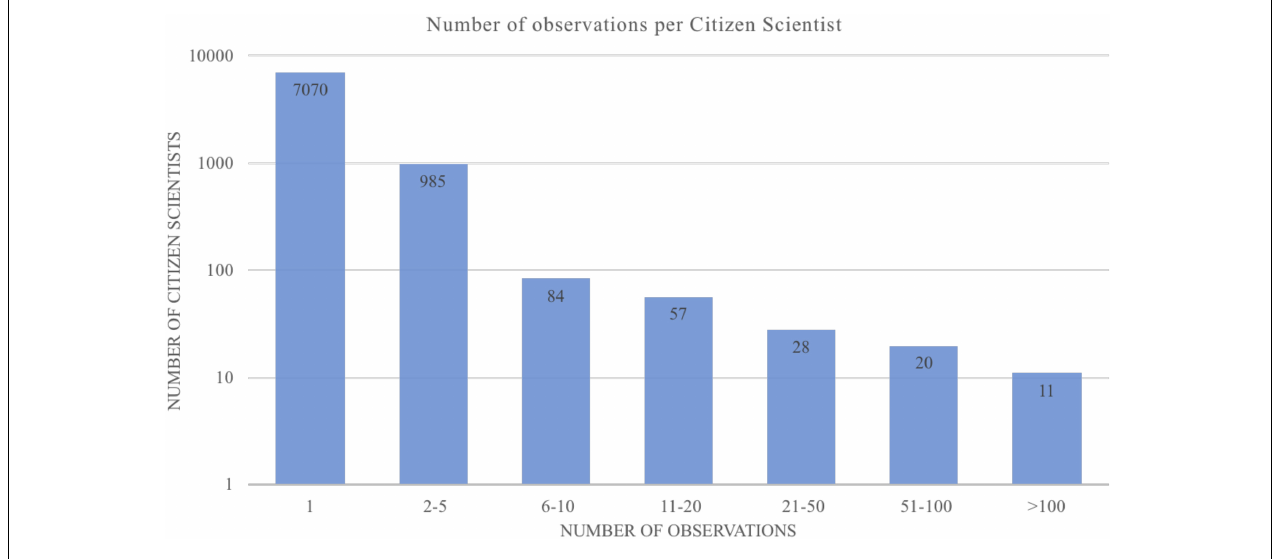
FIGURE 4 | Number of observations submitted per citizen